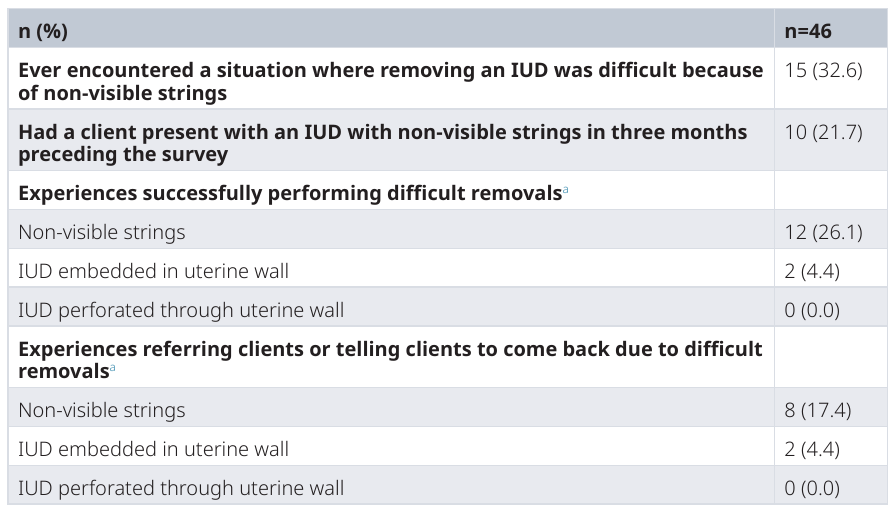
Table 5. Experiences with difficult IUD removals among providers who have ever removed an IUD. n (%) n=46